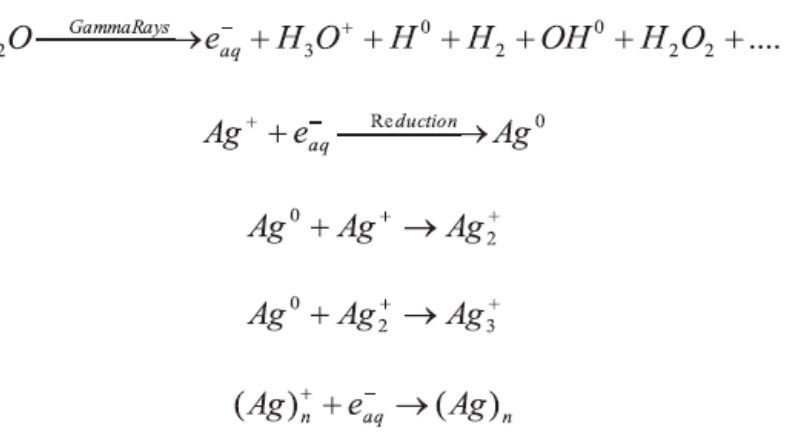
Figure 16. Mechanism of silver ion reduction by gamma radiation. Copyright permission from [141].